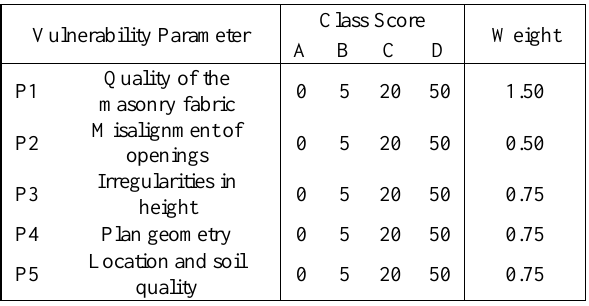
Table 2. Structure of the Ferreira Method.